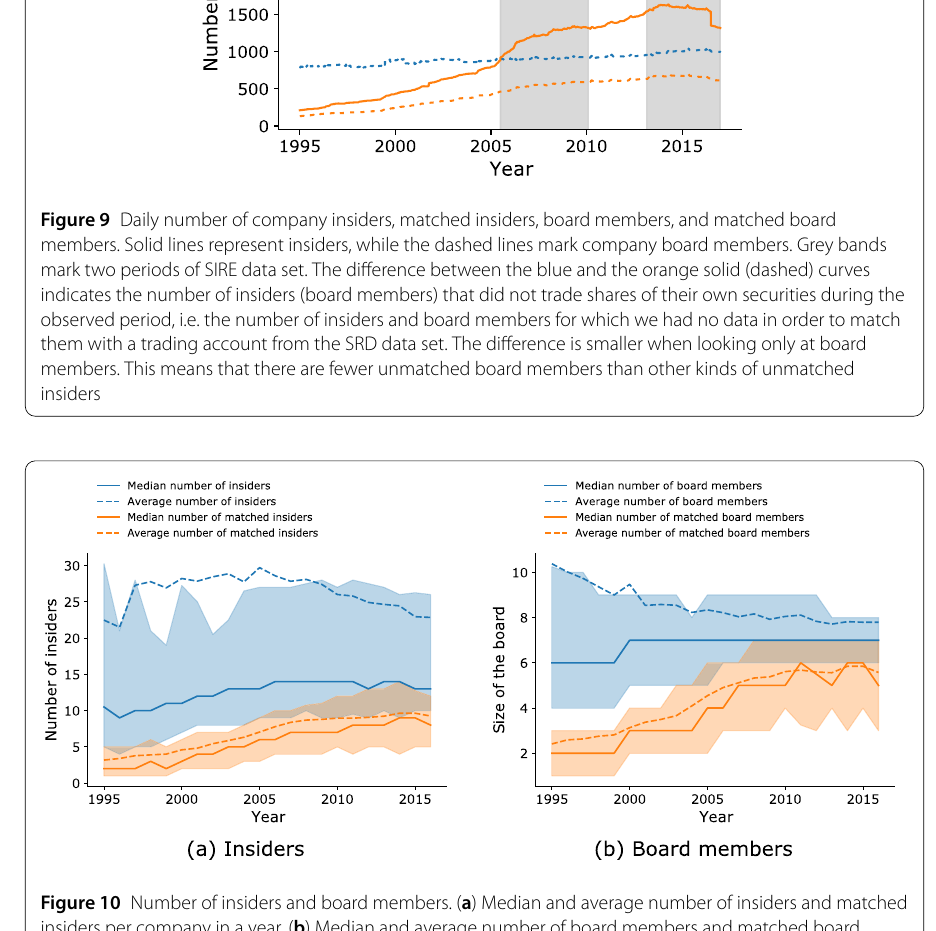
In our data set, there are approximately 26.2 ( ± 2.4) insiders and 6.9 ( ± 2.3) matched insiders 15 on average per company in a year (Fig. 10 (a)). The blue dashed line shows the average number of insiders per company in a year, ranging from 21.5 to 29.7 insiders. The orange dashed line in Fig. 10 (a) shows the average number of matched insiders and ranges from 3.2 to 9.6. Similarly, the average board size per company is composed of 8.5 ( ± 0.8) board members in a company in a year, out of which on average we identified around 4.4 ( ± 1.3) matched board members (Fig. 10